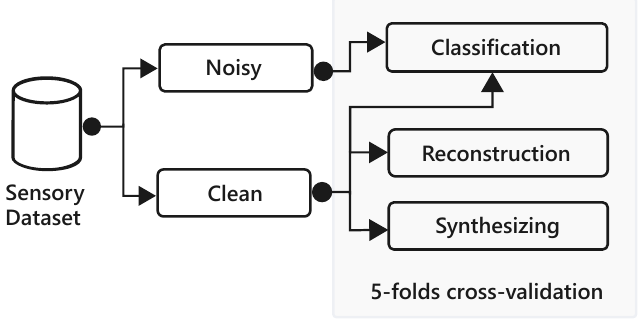
Figure 5. Data split for reconstruction, synthesizing, and classification